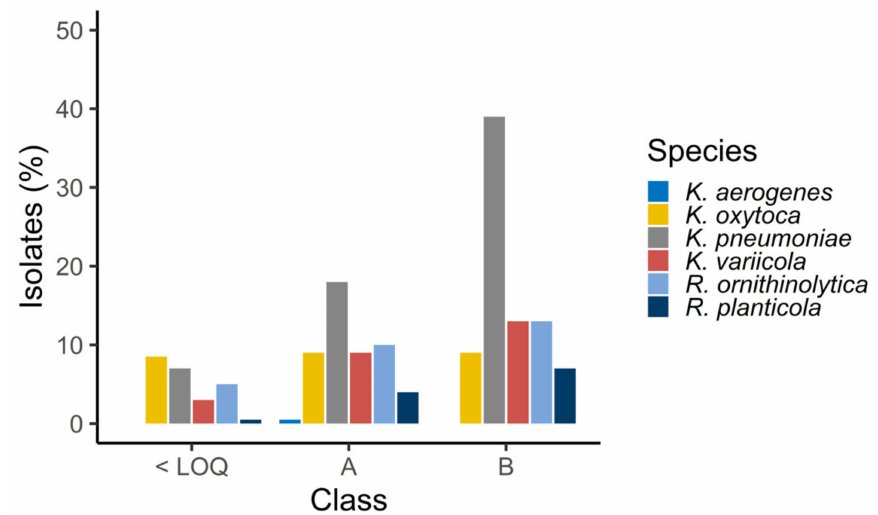
Figure 1. Distribution (%) of Klebsiella spp. and Raoultella spp. isolates recovered from areas of increasing E. coli load according to the EU classification A, B and C. < LOQ: < 18 MPN E. coli / 100 g, A: 18-230 MPN E. coli / 100 g, B: 230-4600 MPN E. coli / 100 g. No results corresponded to E. coli counts above B